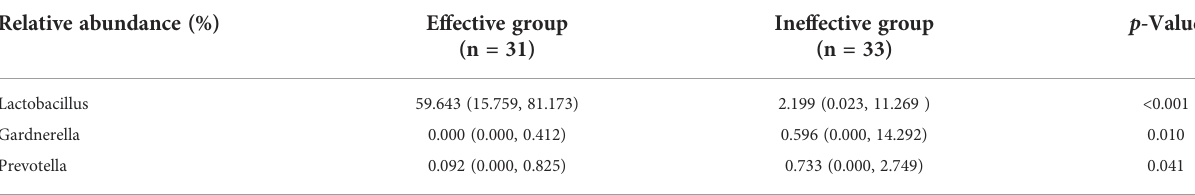
Data presented as median [IQR]. IQR, interquartile